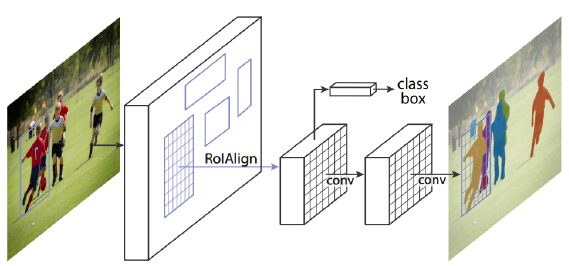
Figure 7. Explained architecture of Mask R-CNN. Image is obtained from